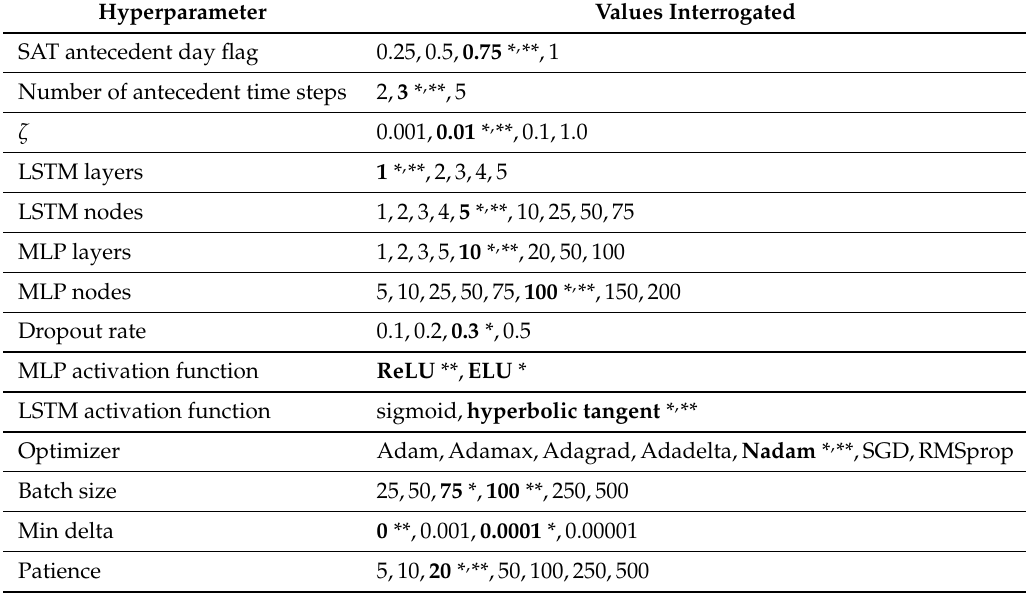
Table 6. Parameters used during hyperparameter tuning. Optimal hyperparameters are shown in